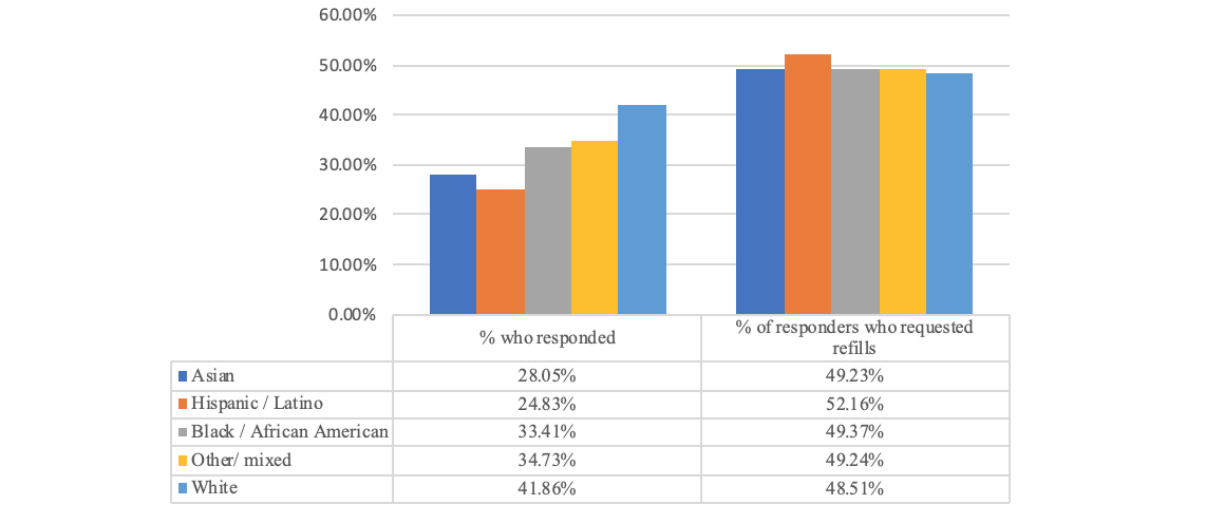
Figure 6. Impact of race/ethnicity on response rates and percentage of responders who request